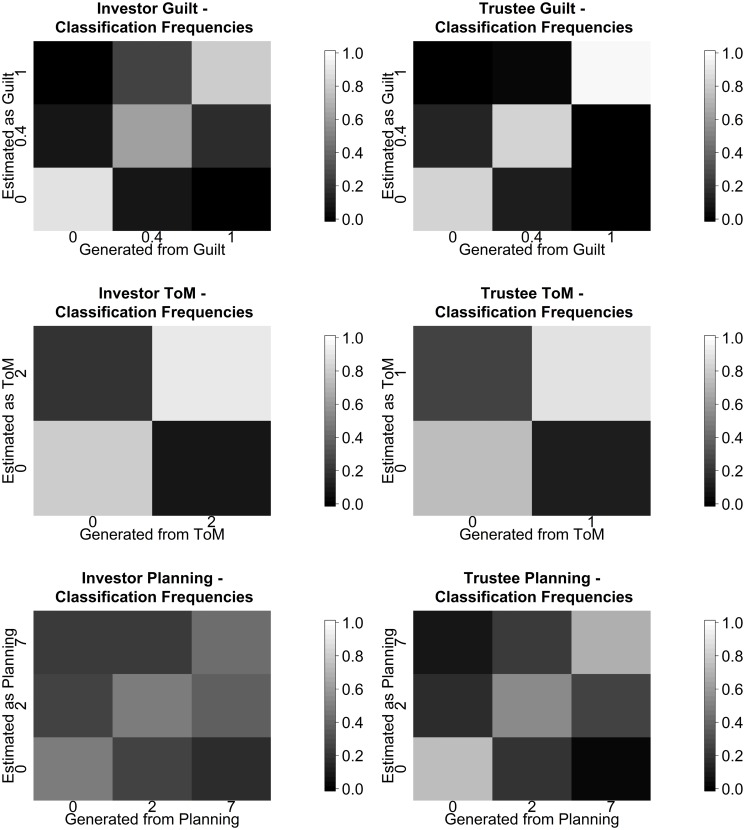
Percentage of inferred guilt, theory of mind and planning horizon for investor (left) and trustee (right) as a function of the true values, marginalizing out all the other parameters.Each plot corresponds to a uniform mix of 15 pairs per parameter combination and partner parameter combination.